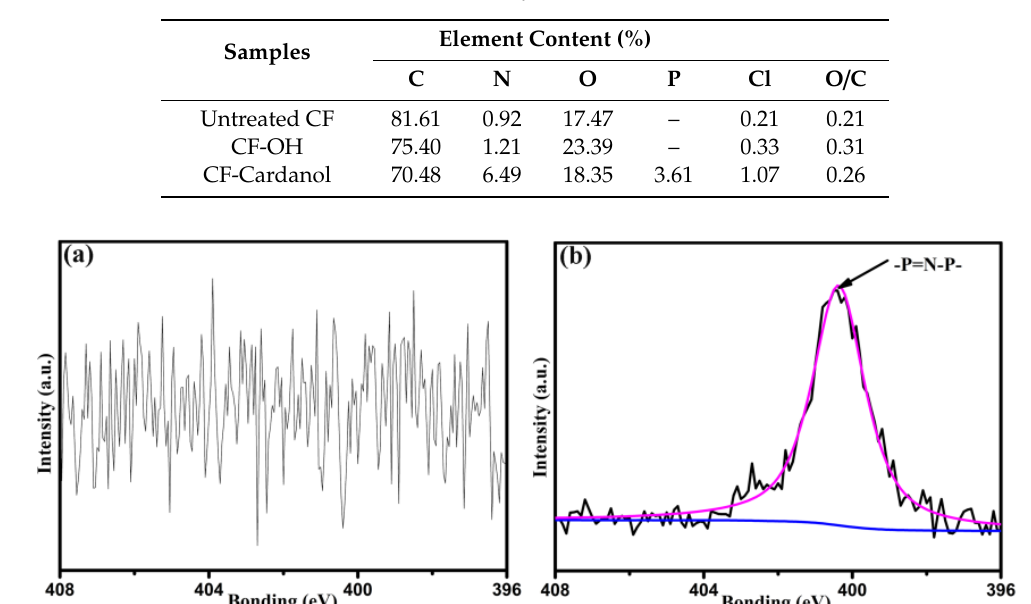
Figure 2. High-resolution XPS N 1s curve fitting for the CFs: ( a ) untreated CF and ( b ) CF-cardanol.